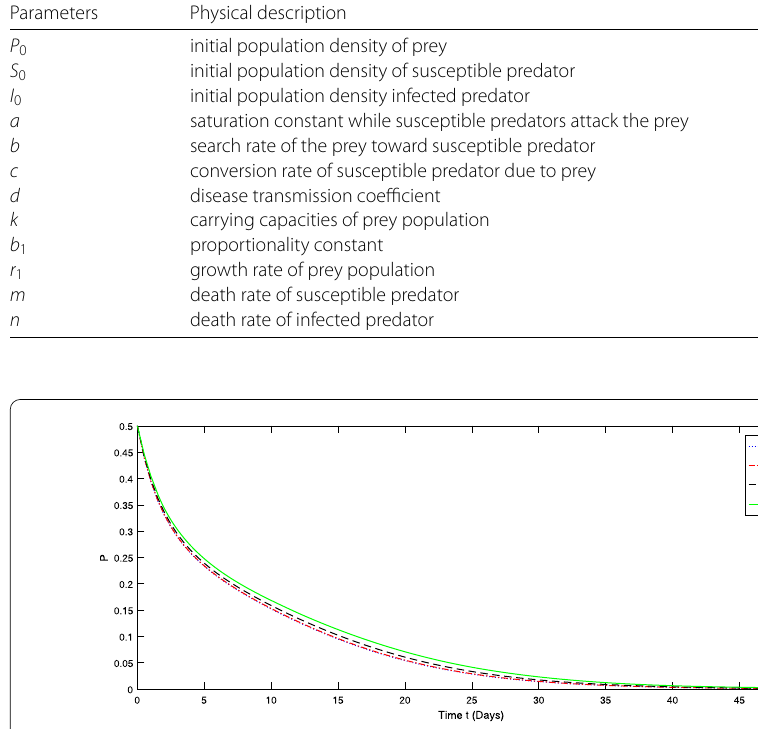
Figure 1 Graphical representation of numerical solution for specie P at various fractional orders of the considered model (4)